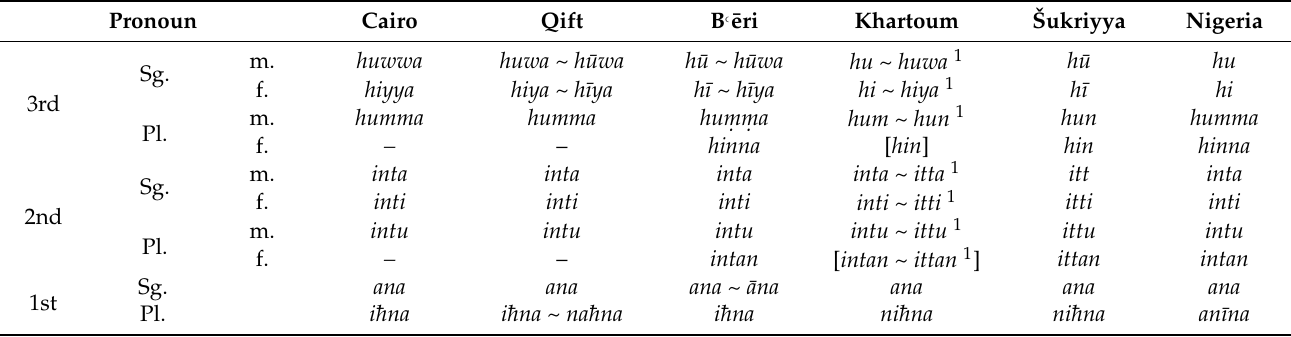
Table 3. Independent Personal